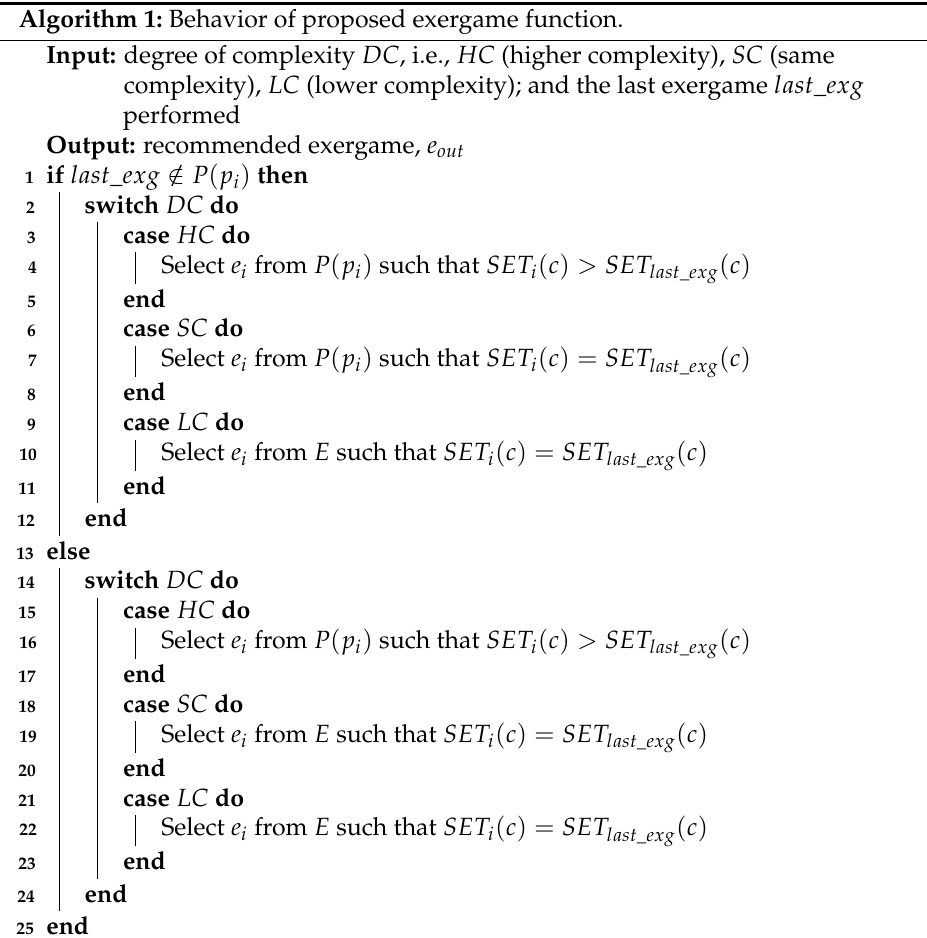
Algorithm 1: Behavior of proposed exergame